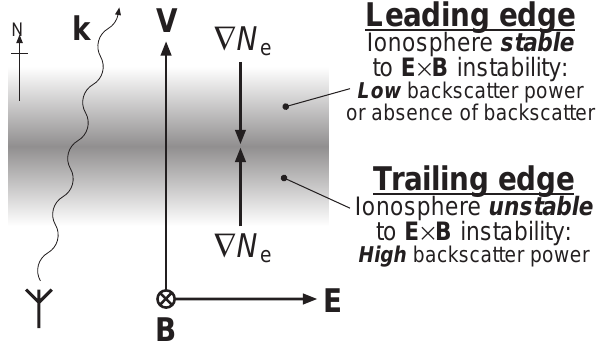
Fig. 5. A schematic diagram indicating the region of the polar patches most likely to give rise to ionospheric irregularities from which the radar can scatter. B is the terrestrial magnetic field, E the convection electric field, V the direction of plasma drift, and k the radar wave vector. ∇ N e indicates the direction of horizontal plasma density gradients at the leading and trailing edges of the po- lar patch. Irregularity generation occurs where V and ∇ N e have a parallel component, i.e. at the trailing edge of the